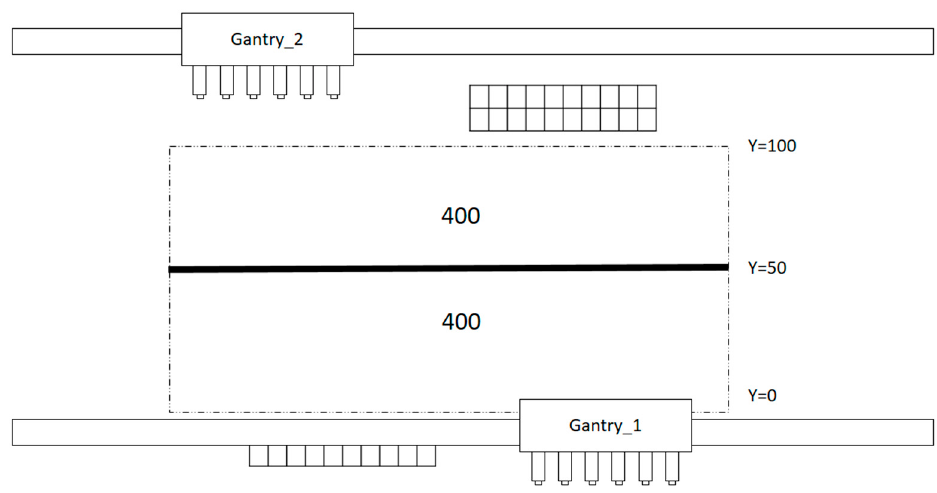
Figure 6. Component allocation.